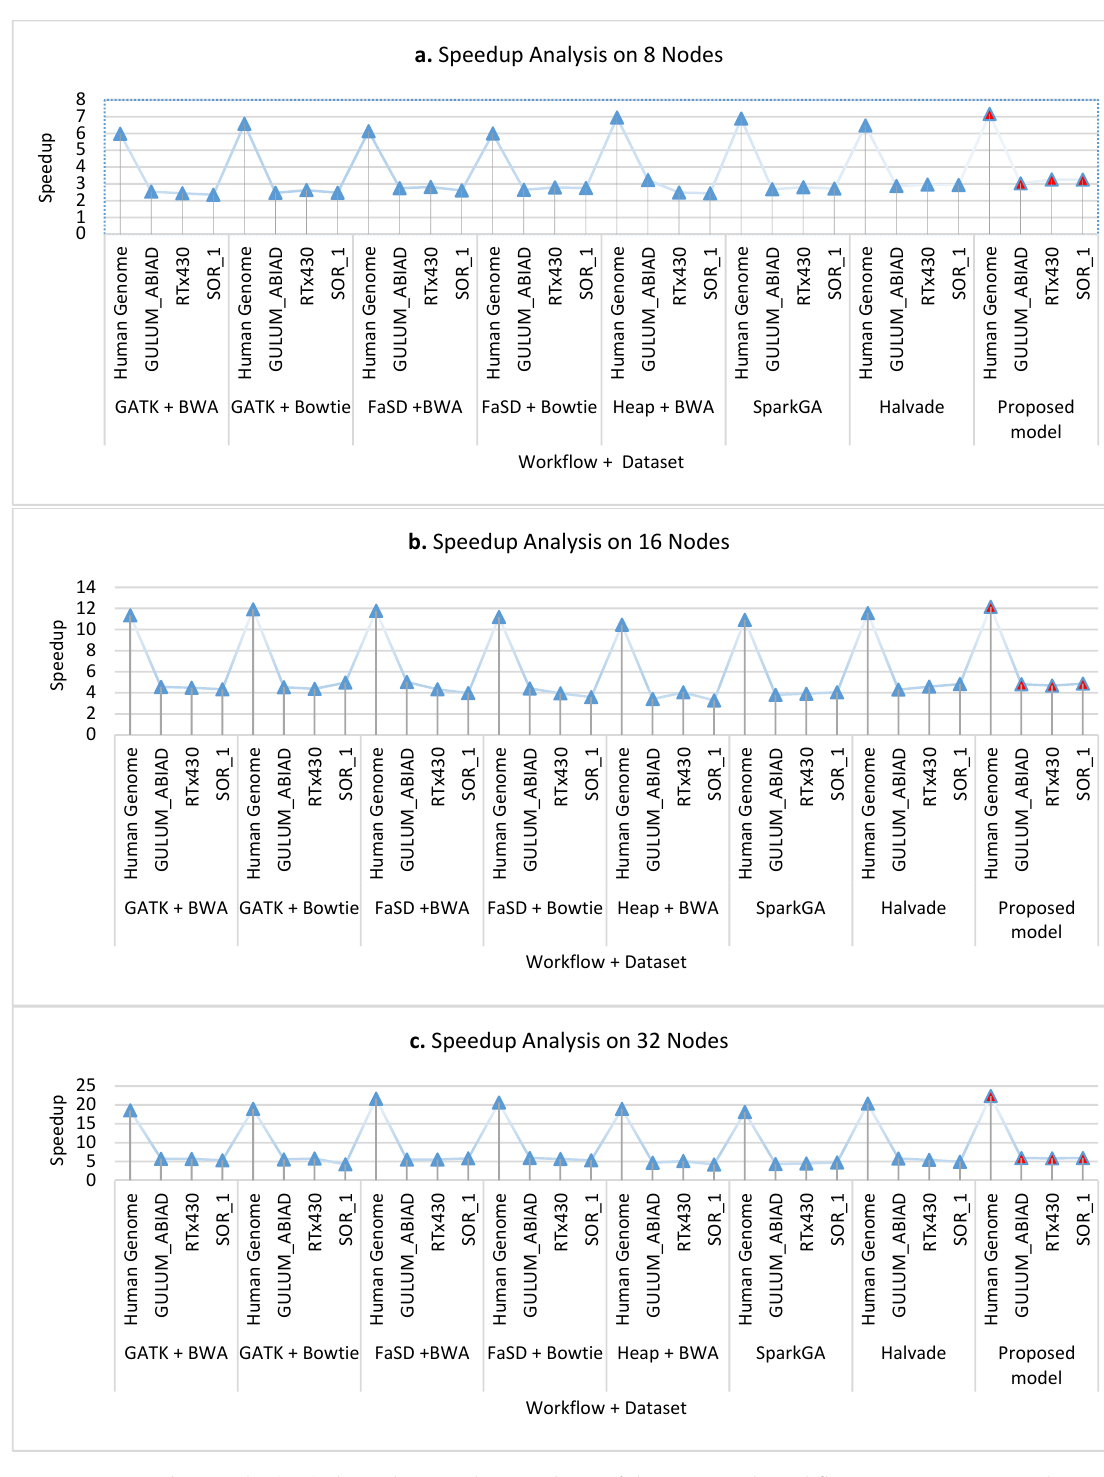
Figure 8. The graphs ( a – c ) show the speed up analysis of the proposed workflow in comparison with existing workflows running on various nodes: 8, 16, and 32 nodes respectively. On all number of nodes, the proposed workflow achieved higher speedup as compared to other workflows on both Sorghum and Human genome datasets. Results analysis elucidates that the proposed workflow is robust in gaining speed up.